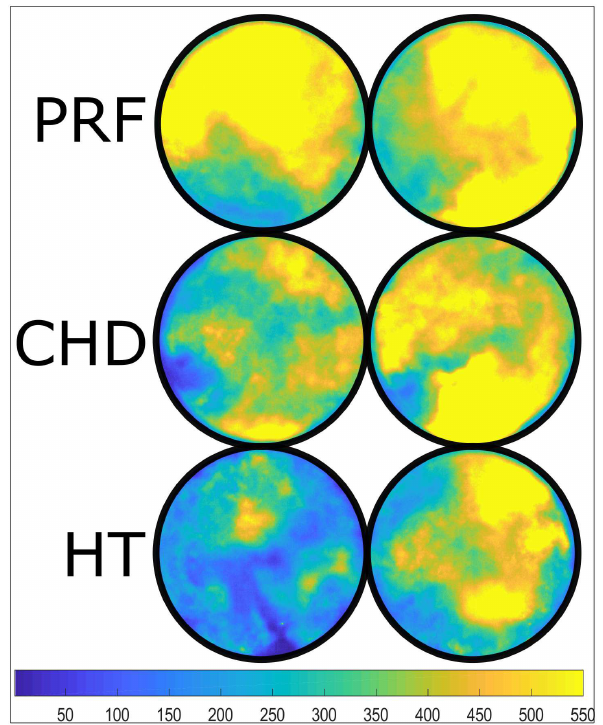
Figure 14. Sample images from a combustion cycle. Images shown are for each fuel, at the two T inlet considered (T inlet 90 ◦ C ( left ), T inlet 115 ◦ C ( right )). Contrast adjusted so all flame is visible (very low intensity flame shown as light blue). The images are taken from one cycle at the CAD where peak pressure for that condition was